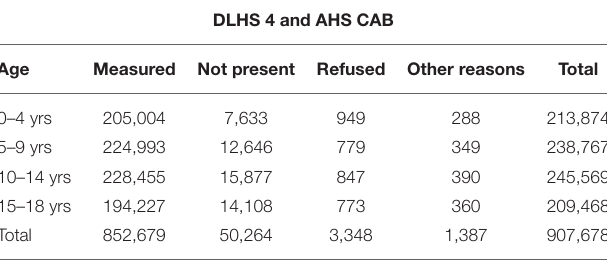
TABLE 1 | Total number of children with height and weight